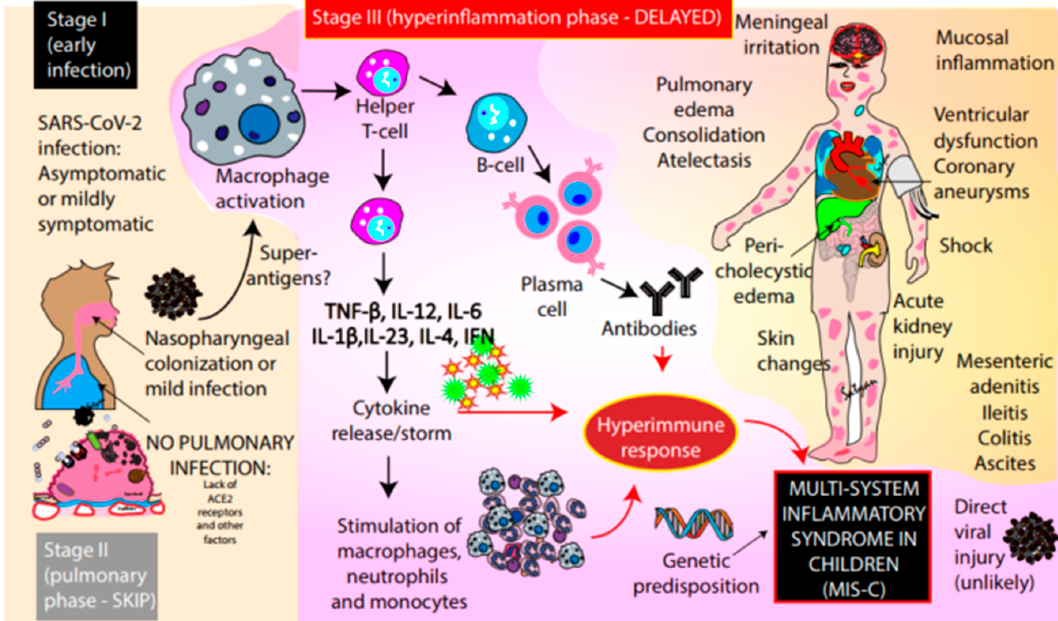
Figure 2. Pathogenesis of MIS-C. Early infection (phase I) with SARS-CoV-2 is likely to